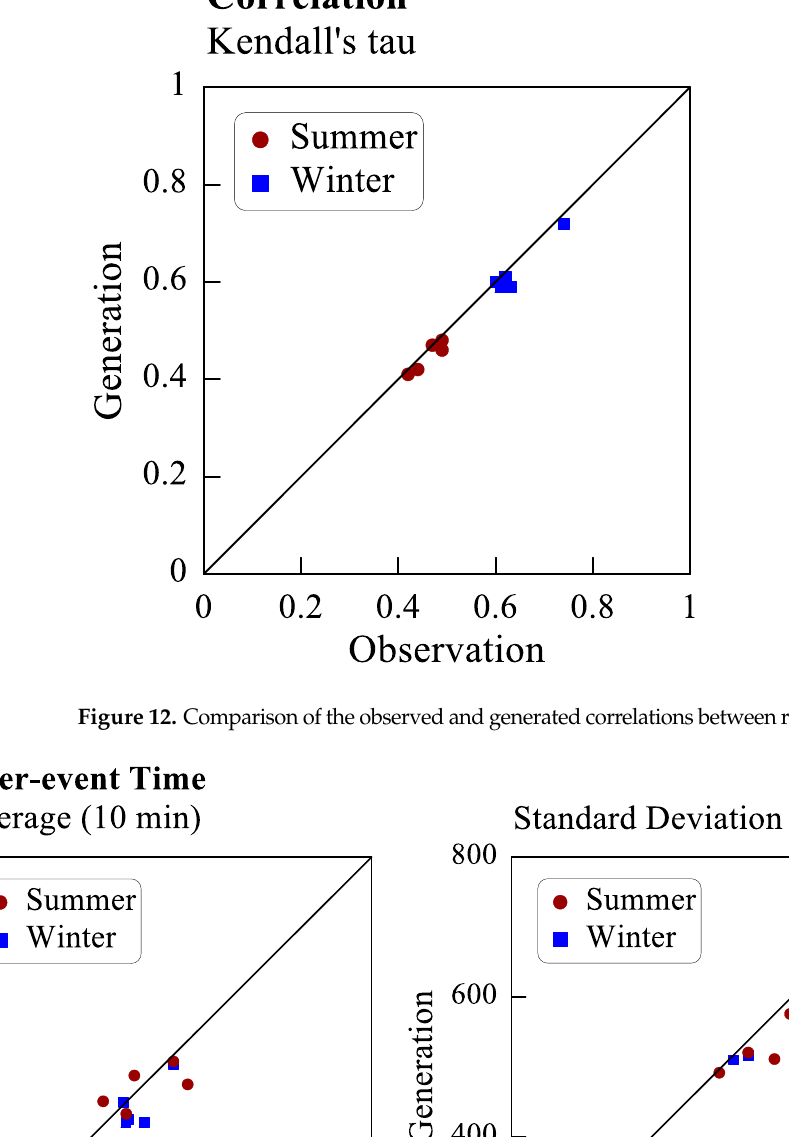
Figure 11. Comparison of the average and standard deviation values obtained for the observed and generated rainfall duration.